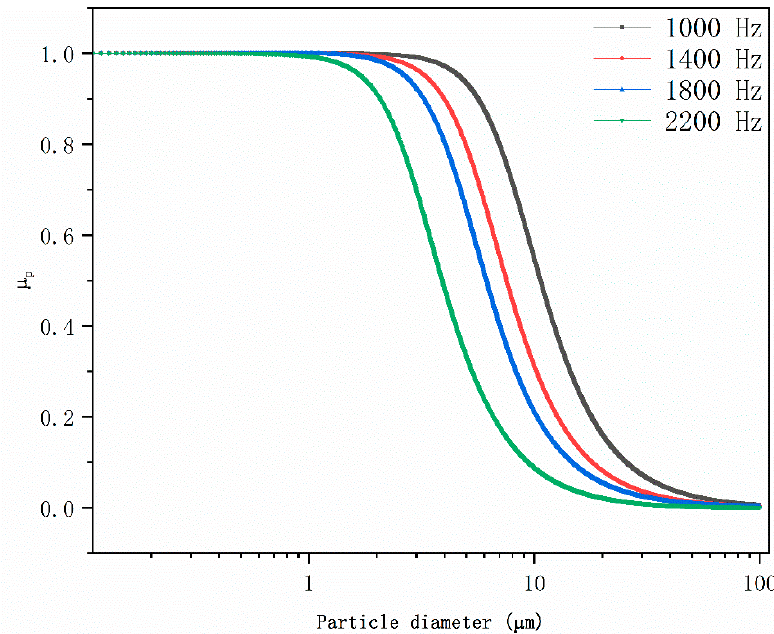
ffi cient, particle size, and frequency of